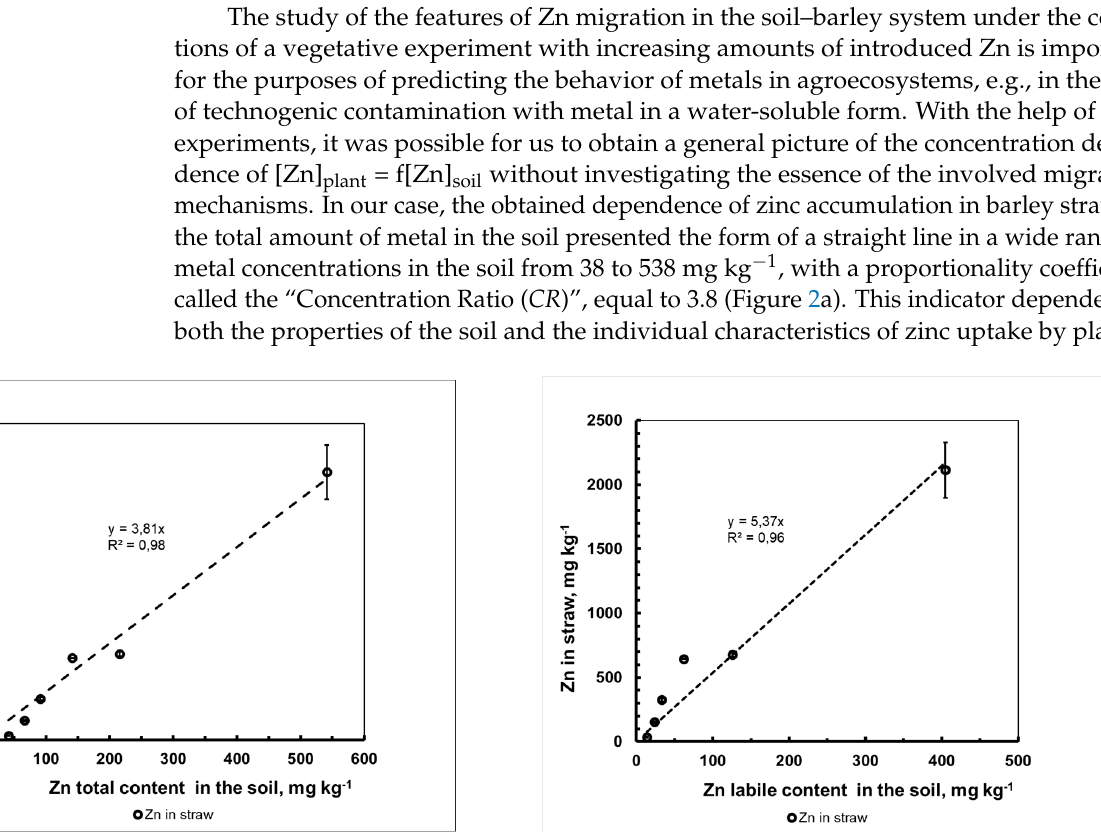
Figure 1. The change in the content of the labile form of Zn in Albic Retisol (Loamic, Ochric) soil (mean value ± standard deviation; n = 3). Data are from the vegetation experiment I.